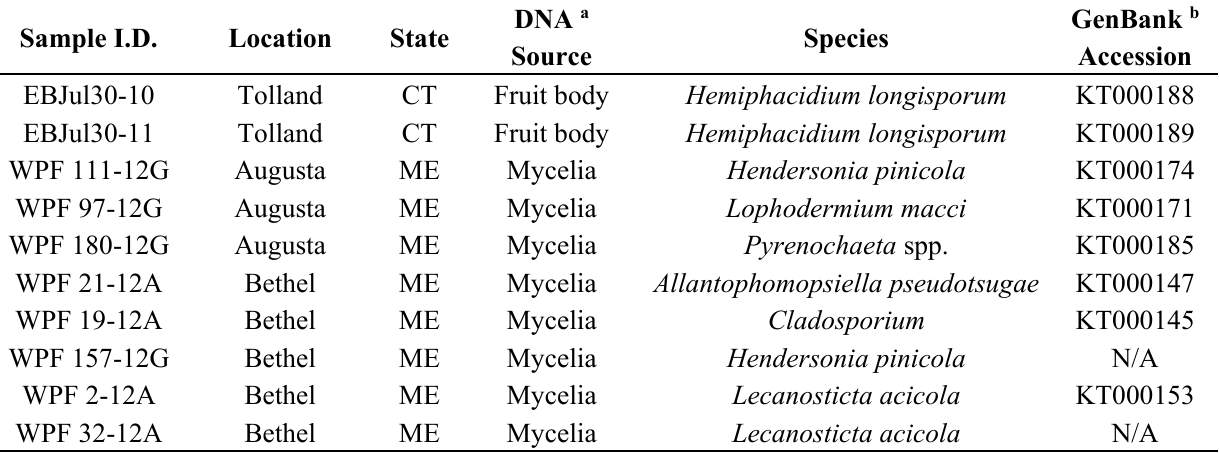
Table 1. Cultured isolates or fruiting bodies of fungi recovered from symptomatic white pine needles in the northeastern United